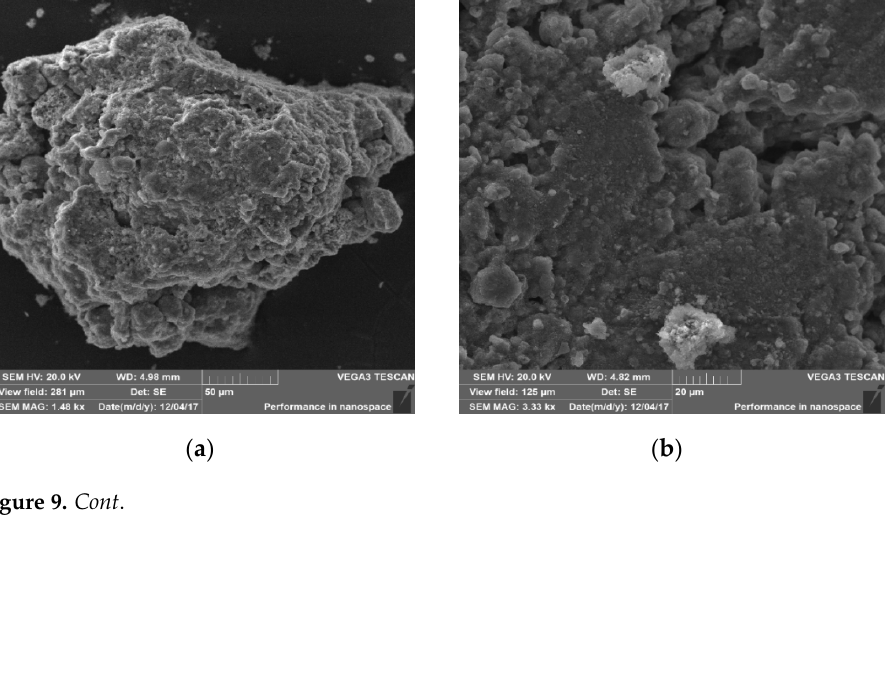
( d ) Figure 9. Results of studying the microstructure of the carbonised samples: ( a , b )—general view; ( c )—CaCO 3 crystals; ( d )—products of the β-C 2 S hydration. 5 . Conclusions An analytical scientific review of the disposal of production waste and, in particular, of solid nepheline sludge and gaseous carbon dioxide determined that the solid waste is primarily accumulated in the dumps of industrial enterprises (nepheline sludge) and